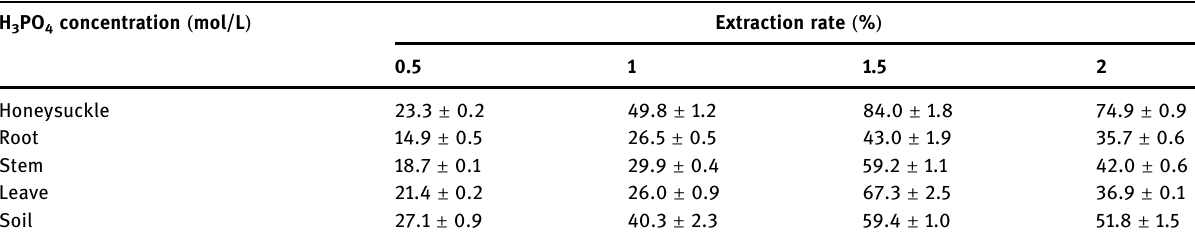
Table 7: Research data on As extraction with di ff erent concentrations of phosphoric acid ( n = 3 ) H 3 PO 4 concentration ( mol/L